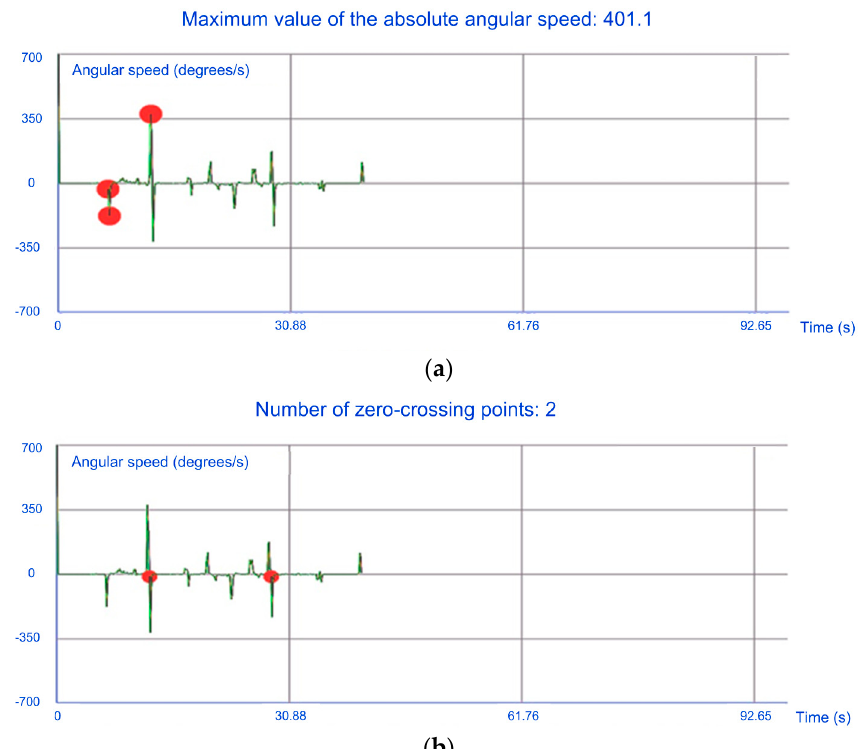
Figure 6. Graphs representing the angular speed of the steering wheel extracted by the app: ( a ) with the positions where the maximum value of the absolute angular speed is updated and its present maximum value; ( b ) with the positions where zero-crossing points are computed and a counter with the present number of zero-crossing points.